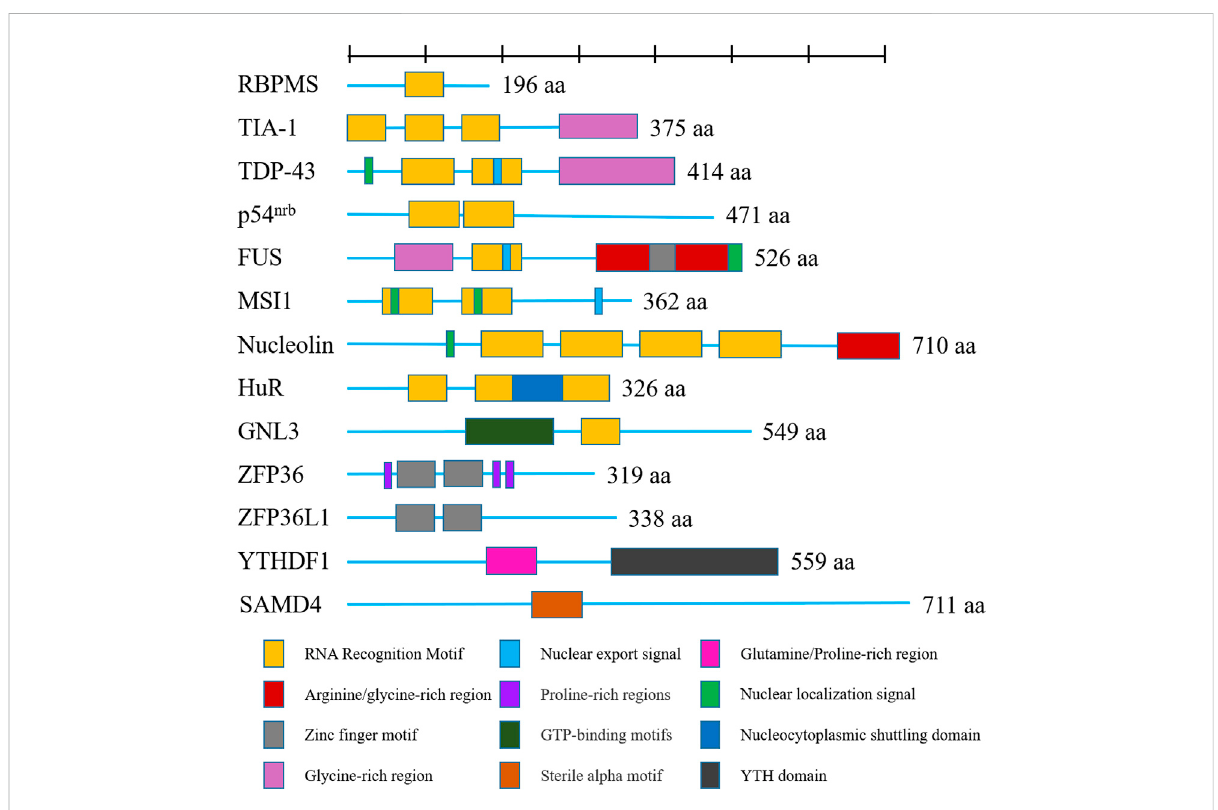
FIGURE 2 ShownarehumanRNA-bindingproteinsplayingamajorroleinosteoarthritisasdiscussedinthisreview.Domainsarecolor-codedandproteins are scaled to amino acid length. Different colors represent different functional